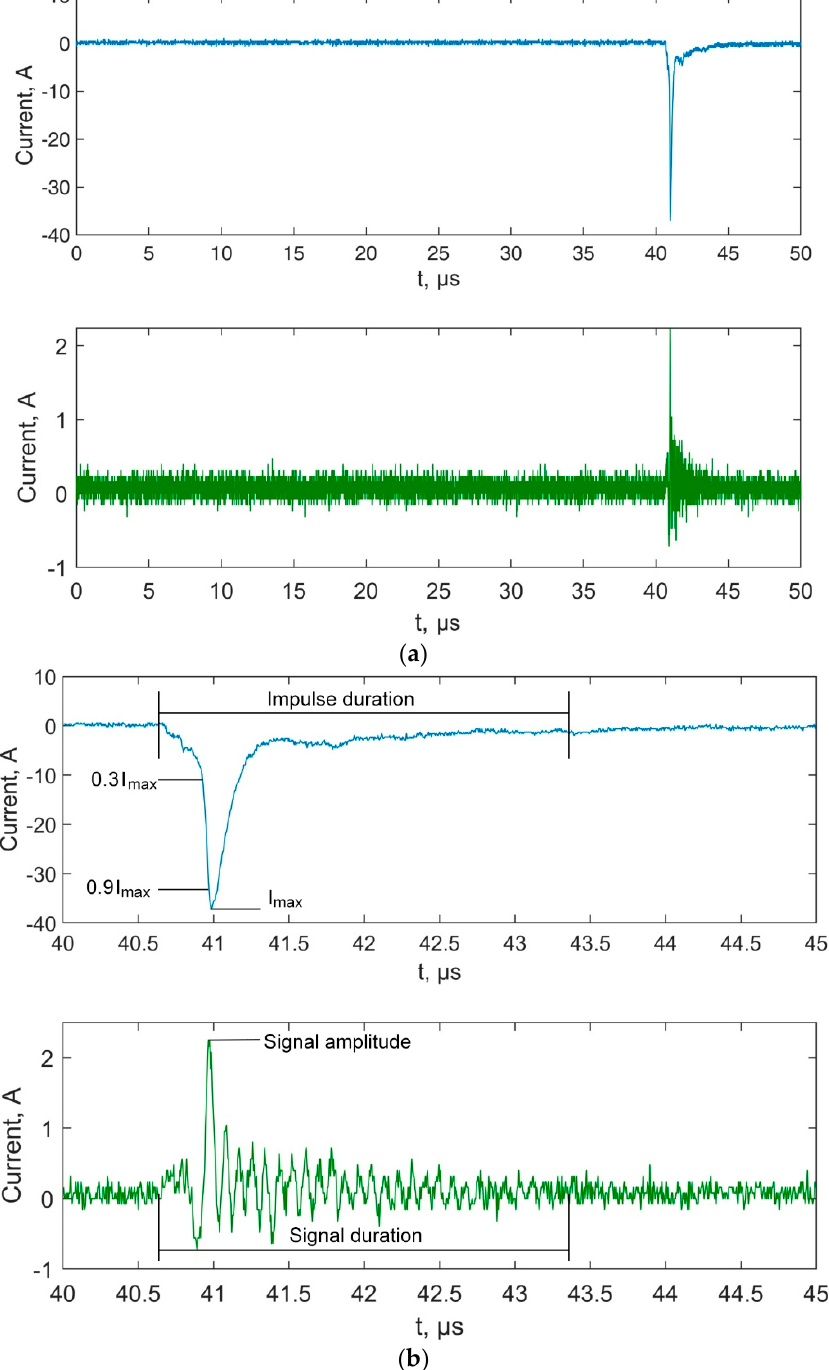
Figure 5. ( a ) Oscillograms of the upward streamer discharge current (upper) and induced electromagnetic effects (bottom). ( b ) Focused oscillograms of the formation of the upward streamer discharge current (upper) and induced electromagnetic effects (bottom).